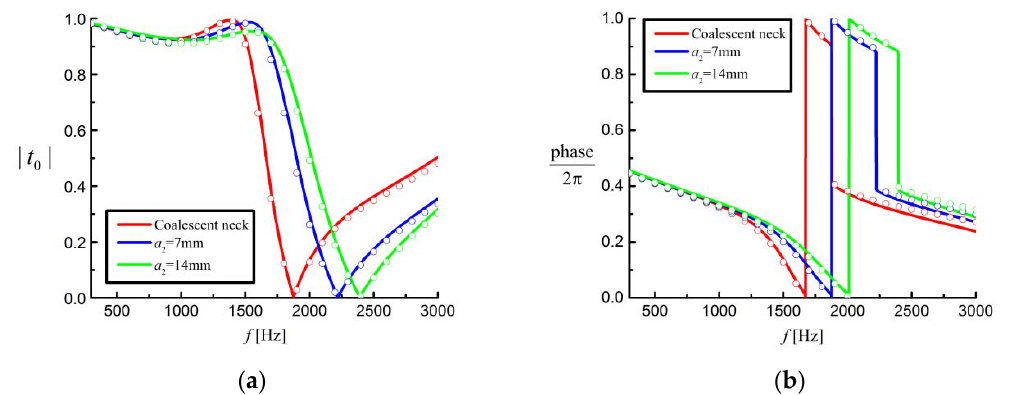
a on transmission prop- 2